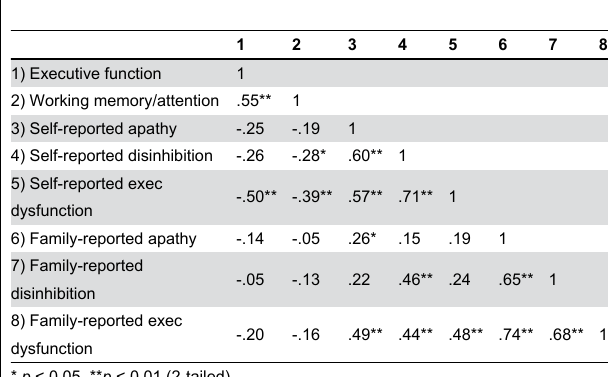
Table 1. Demographic characteristics, FrSBe ratings, and cognitive domain scores as a function of injury status.